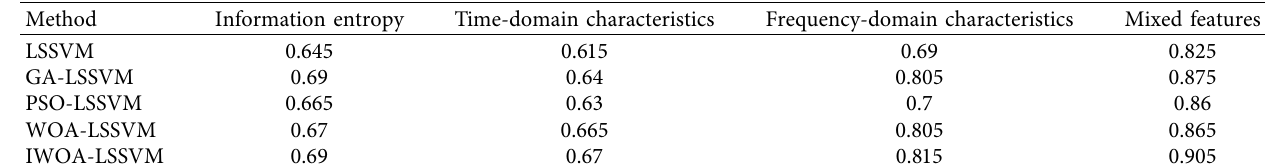
Table 5: Classification accuracy using different features.